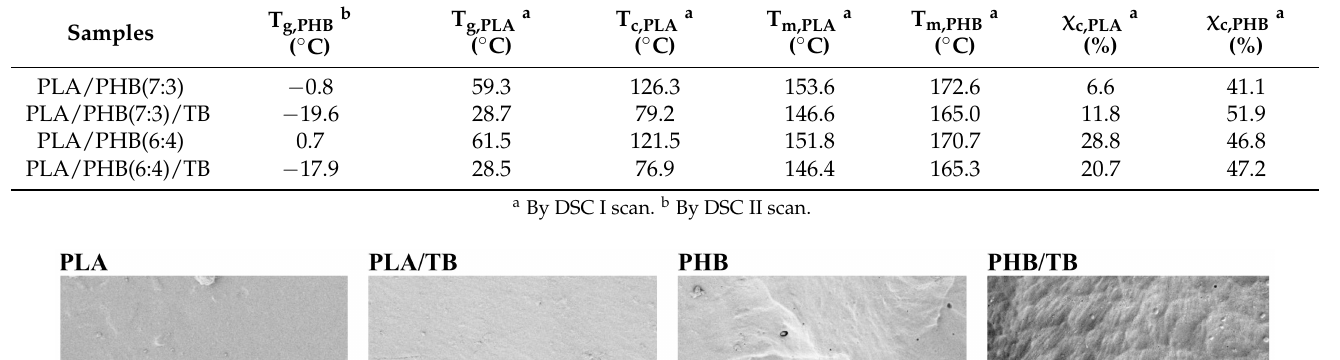
Table 3. Thermal characterization data of neat and plasticized PLA/PHB blends.